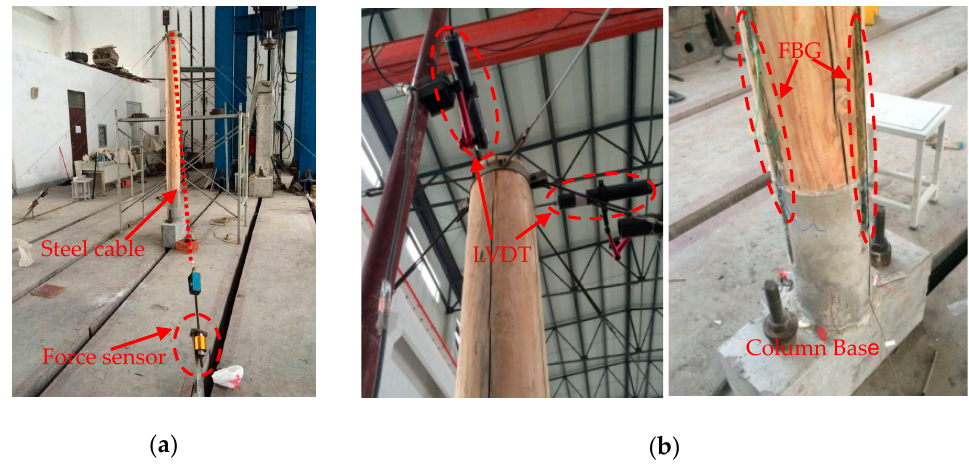
Figure 11. Test setup: ( a ) Overall photo of a single-column pushover test; ( b ) Layout of sensors on the top and foot of the column.